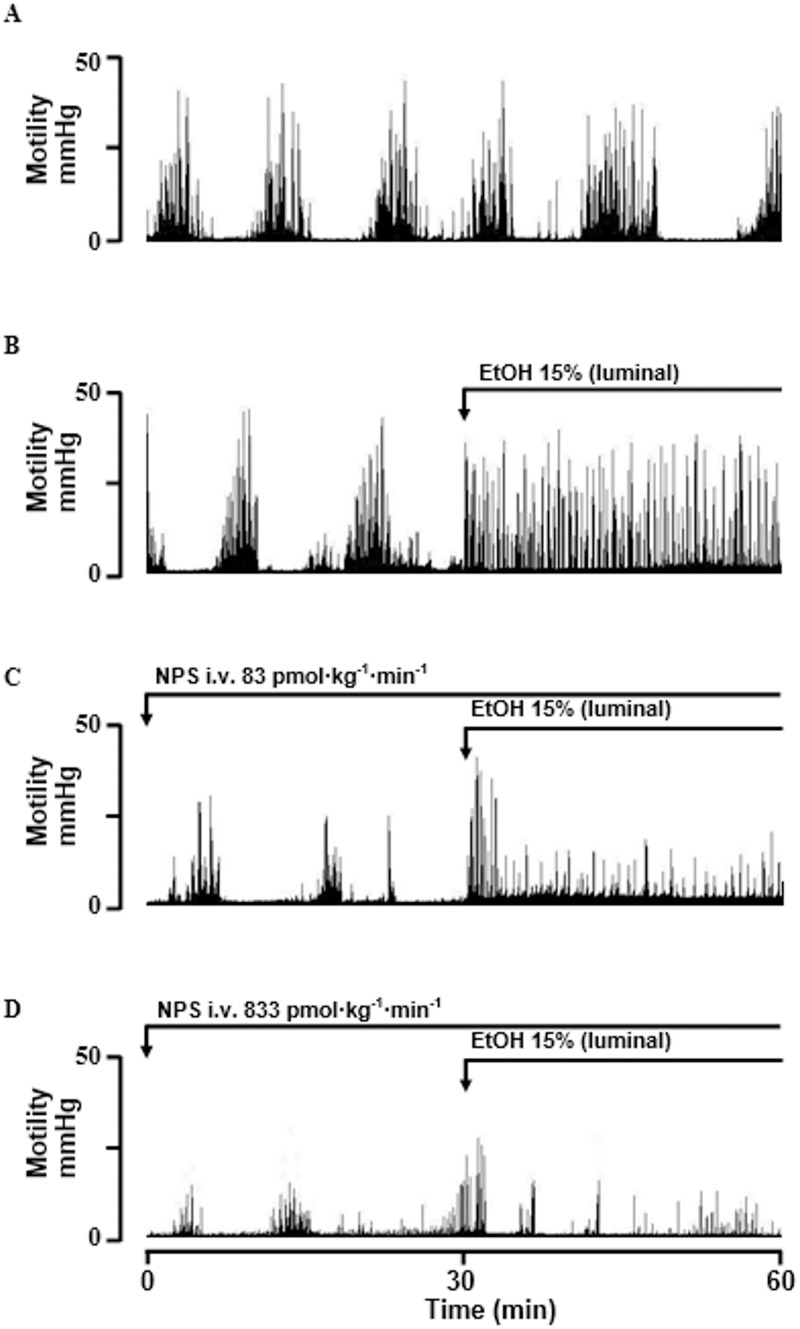
Representative experiment of NPS reducing 15% EtOH-induced increases in intraduodenal pressure (motility).All rats were pretreated with i.v. parecoxib 10 mg/kg approximately 60 min before the experiment started to reverse surgery-induced paralytic ileus. A) Saline perfusion with migrating motor complex (MMC) pattern. B) Luminal 15% EtOH increased motility. C) Continuous i.v. infusion of NPS reduced basal motility (time 0–30 min) and the motility effect of 15% EtOH. D) NPS at 10× concentration further decreased basal motility (time 0–30 min) and further dampened the effect of 15% EtOH.